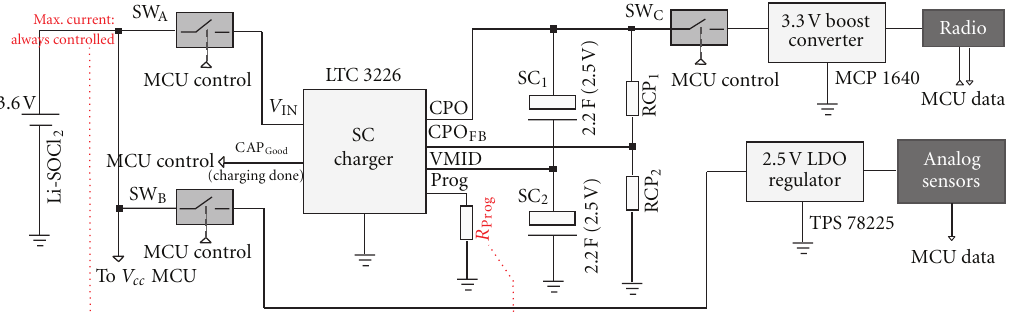
Figure 5: Basic power-matching circuitry for a typical WSN node: intermittent high-power load (bold lines) with a low-current/high-capa- city nonrechargeable